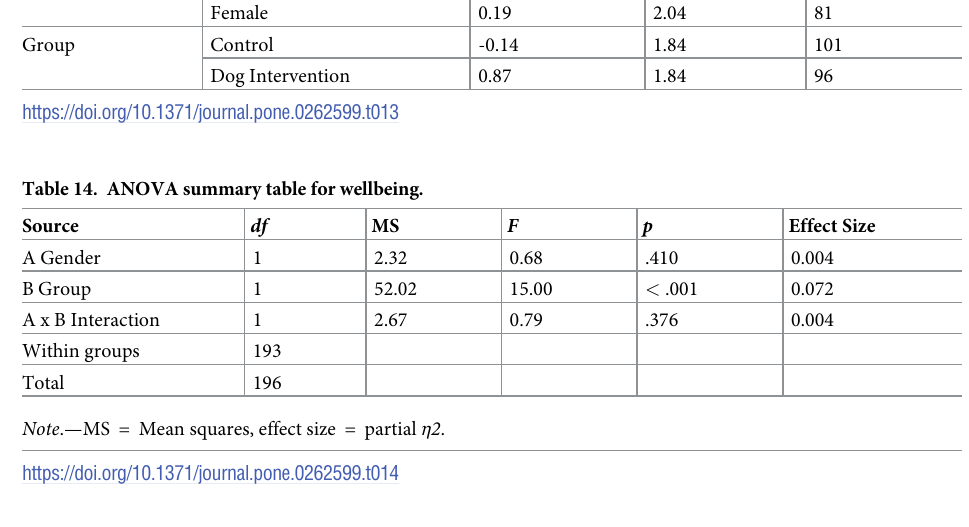
Table 15. Proportion of participants in each change response category and chi-square statistics. Well-being